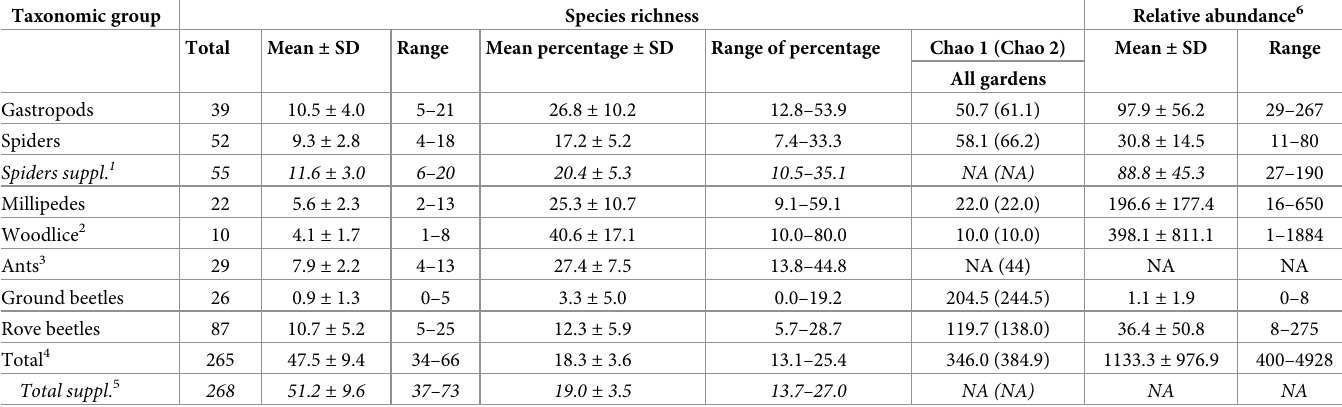
Table 2. Species richness per garden (n =